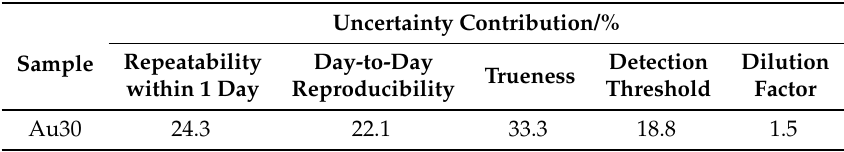
Table A2. Relative uncertainty budget for PTA for the Au30